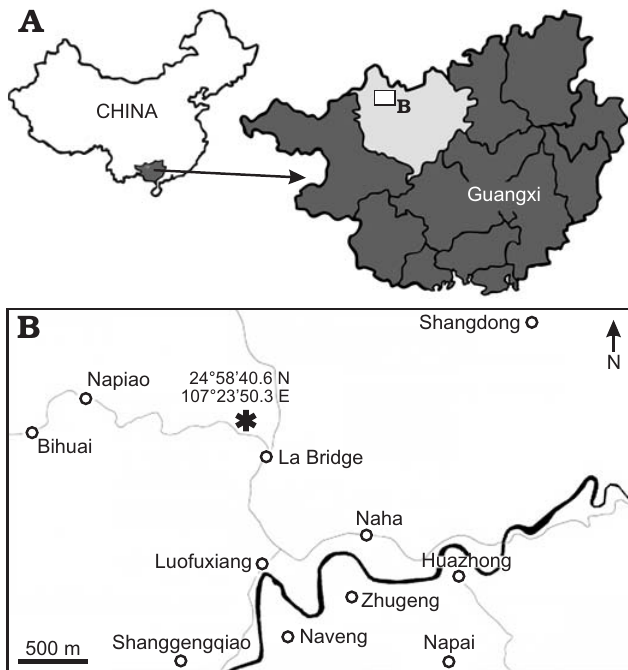
Fig. 2. Maps of China and Guangxi ( A ) adapted from “Croquant” on Wiki- media (licensed under CC BY 3.0). B . Map showing the region of machae- ridian locality (asterisk); adapted from Google